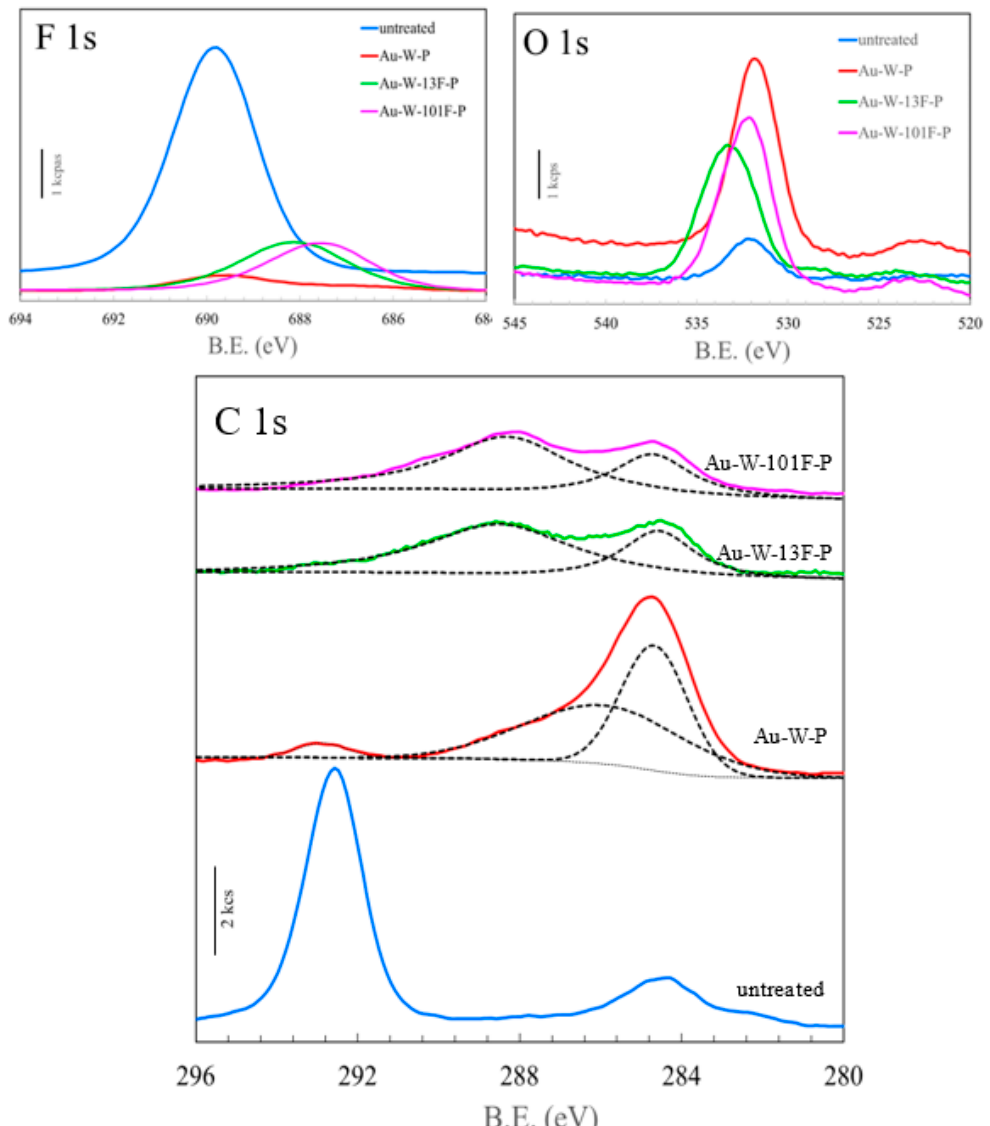
Figure 5. XPS spectra of untreated and modified PTFE